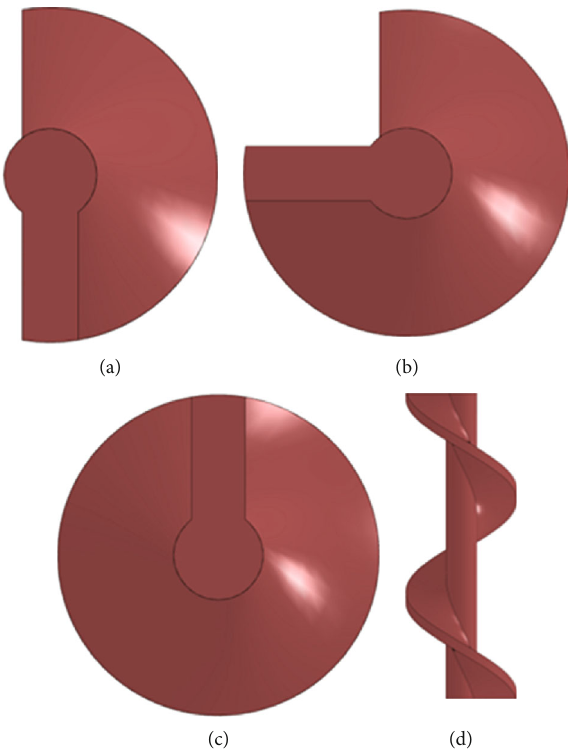
Figure 3: Diagram of impeller with di ff erent rotation